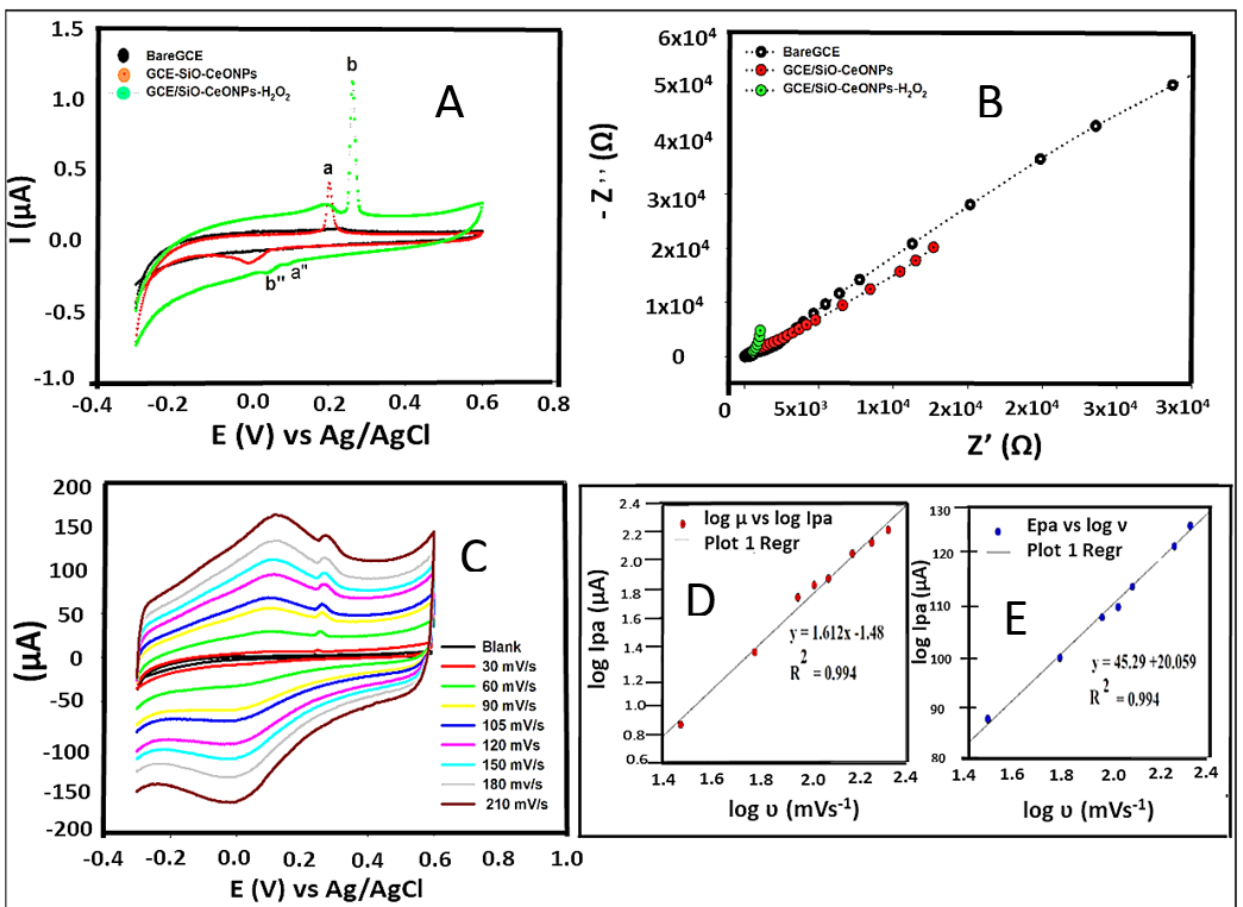
Figure 2. CV results of bare GCE, GCE/SiO-CeNPs, and GCE/SiO-CeONPs after addition of H 2 O 2 , ( A ); EIS results ( B ); Scan rate studies in the presence of H 2 O 2 in 0.1 M PBS (pH 5.5) ( C ); Linear logarithm correlation of peak current vs. scan rate, ( D ). The linear curve of peak potential vs. the logarithm of scan rate, ( E ).